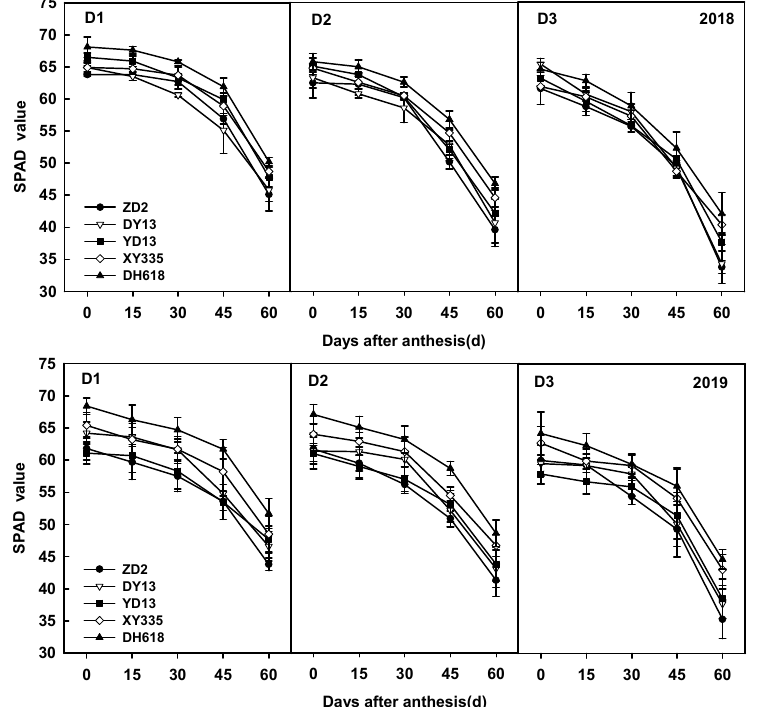
Figure 4. Variation of SPAD value under different densities in 2018 and 2019.